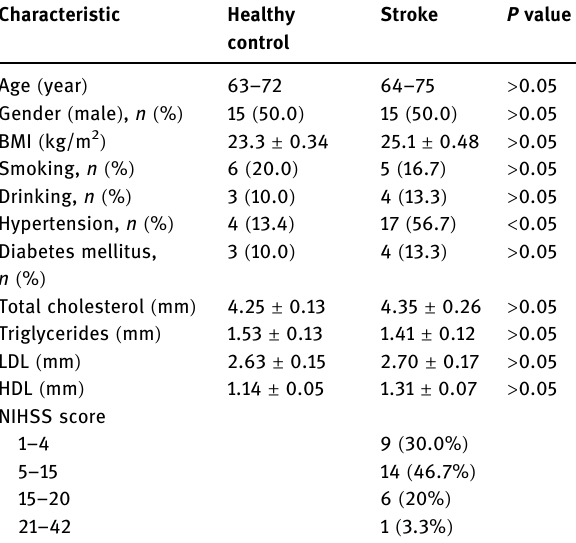
Table 1: Characteristics of